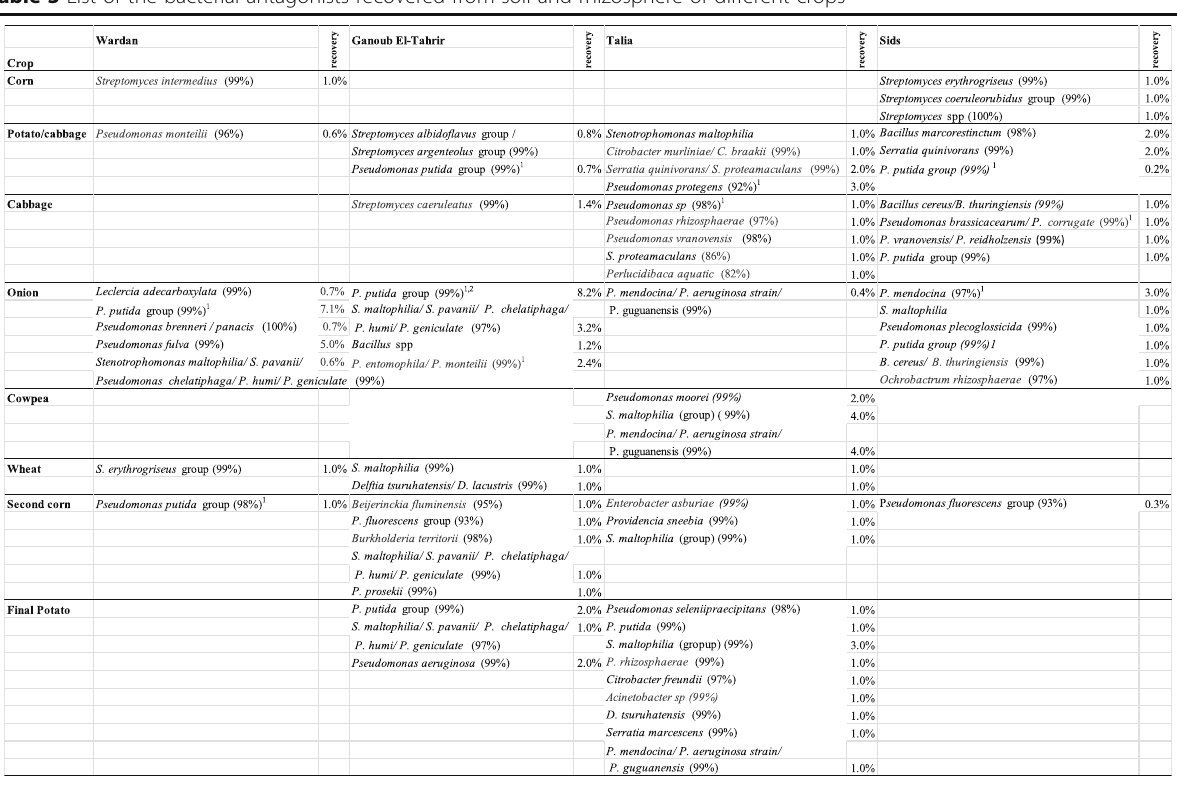
Table 3 List of the bacterial antagonists recovered from soil and rhizosphere of different crops